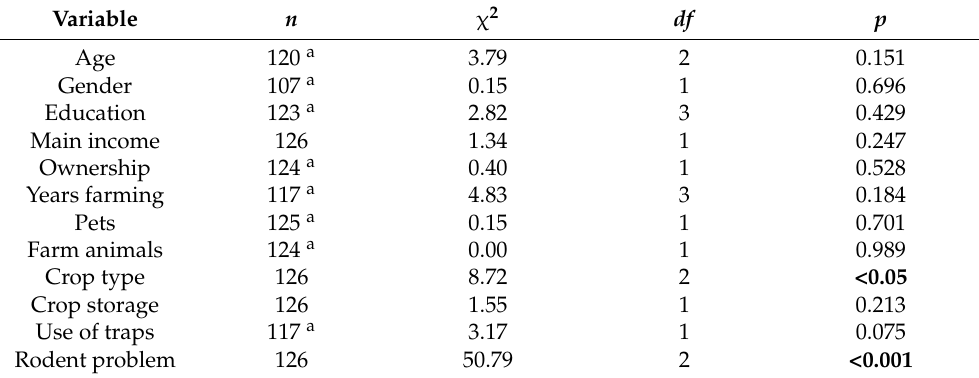
Table 4. Chi-square test statistics determining associations between independent variables and ‘rodenticide use’. Significance is indicated in bold.